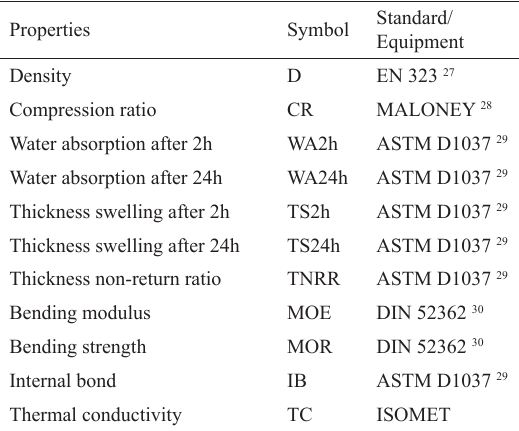
Table 2: Properties evaluated Properties